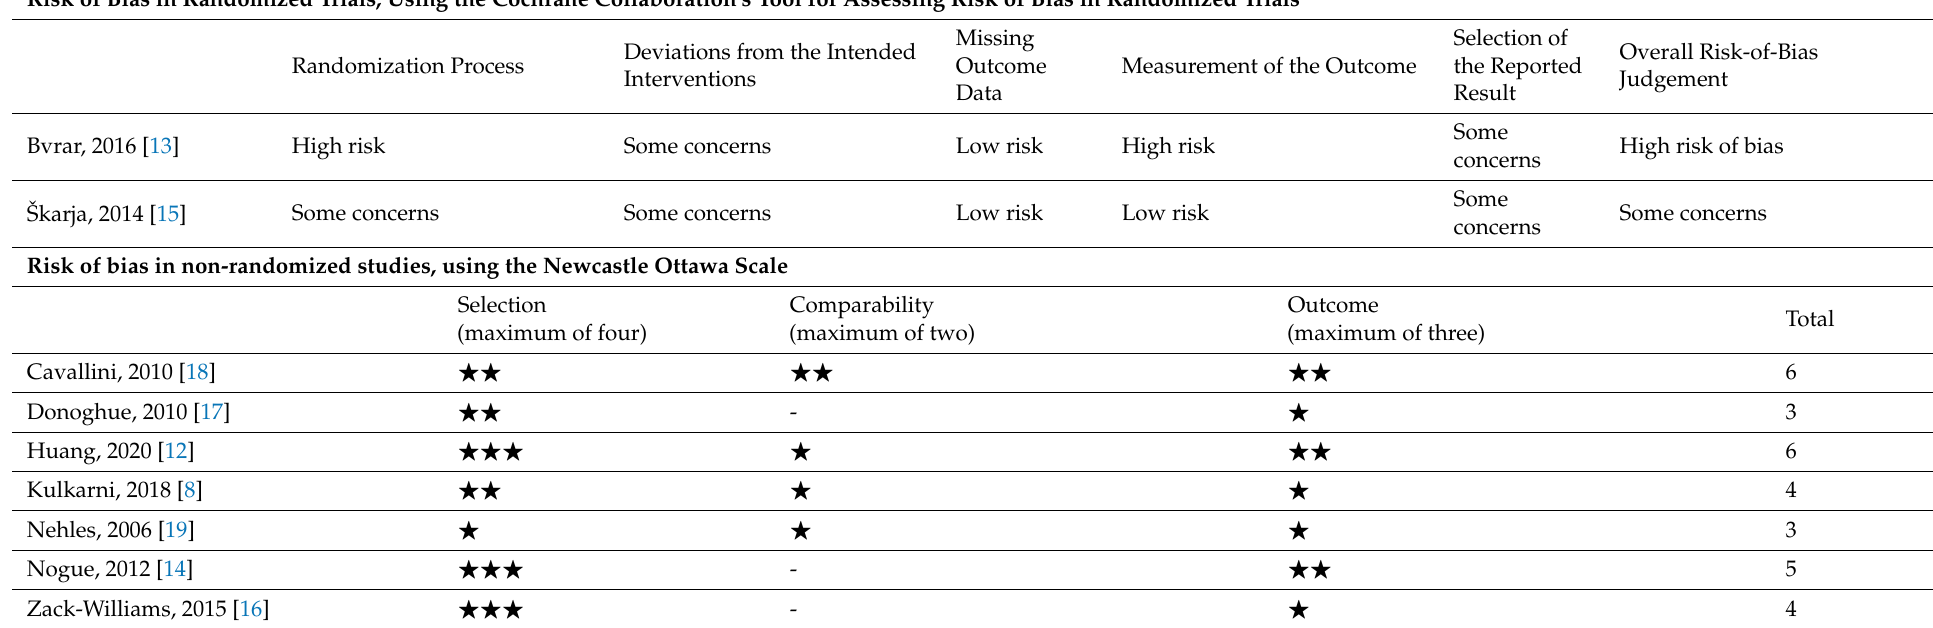
Zero stars representing a high risk of bias, nine stars representing a low risk of